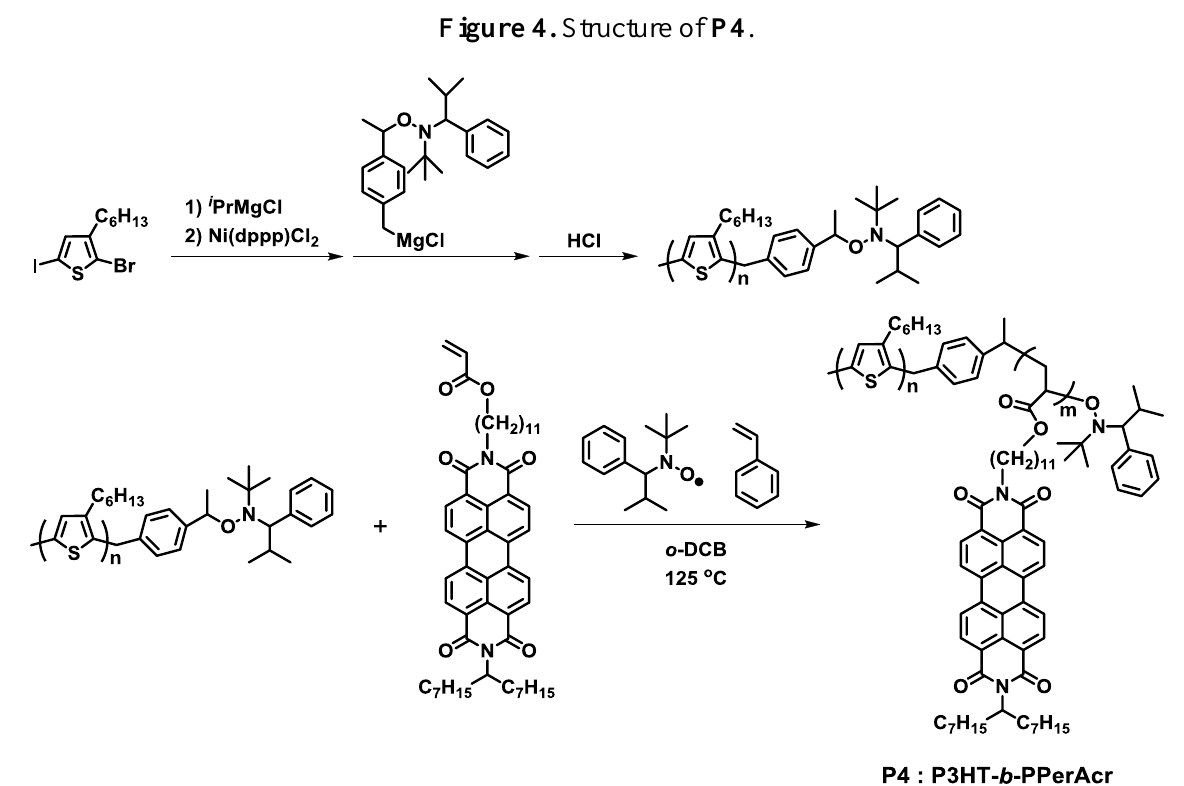
Figure 4. Structure of P4